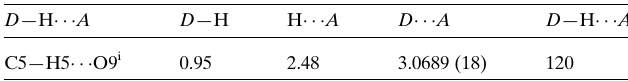
Table 1 Hydrogen-bond geometry (A˚ , (cid:2)